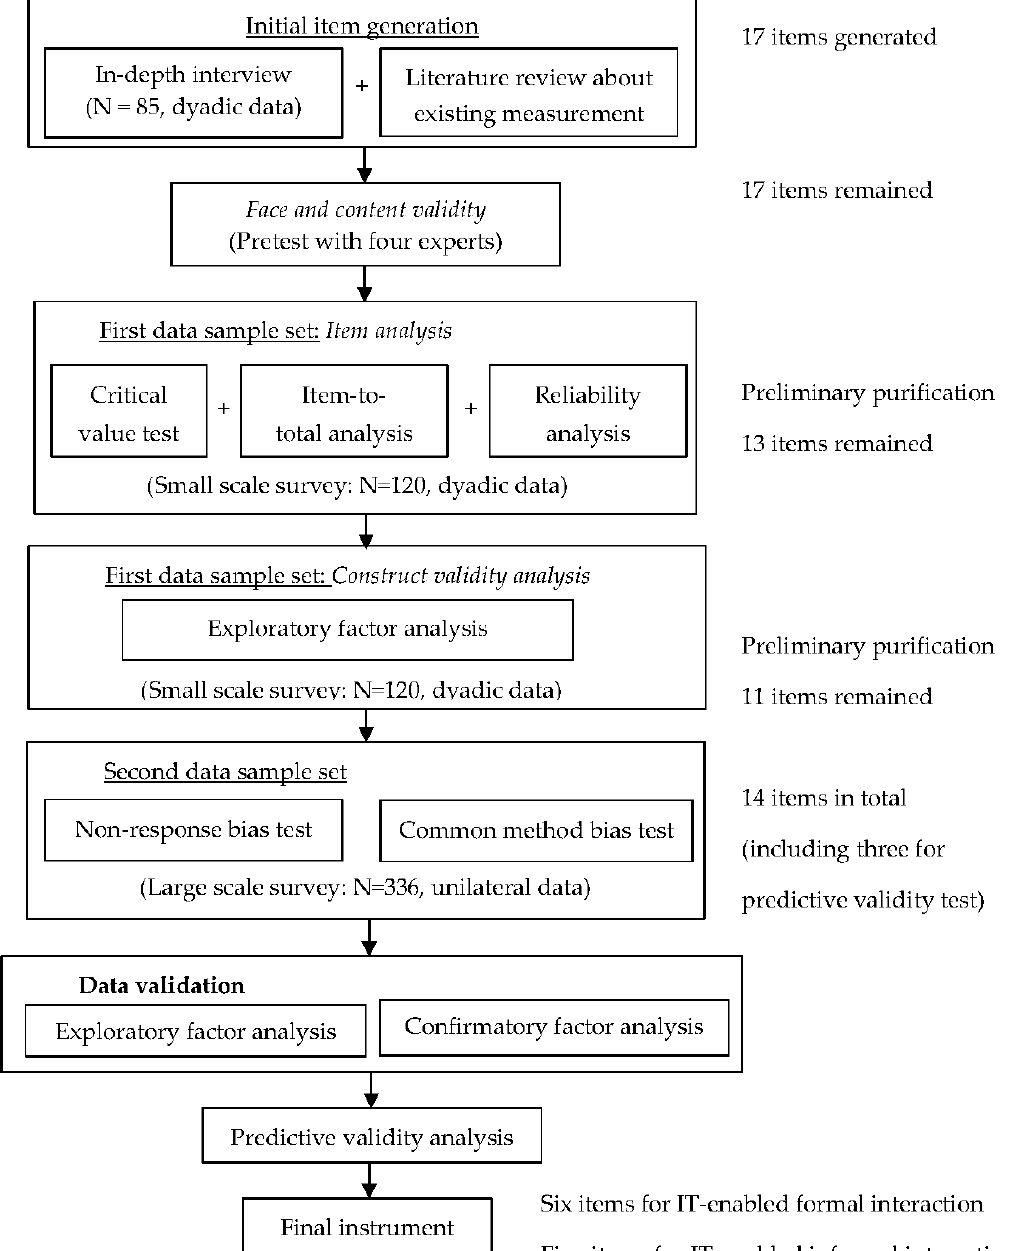
Figure 1. The methodological steps of instrument development.